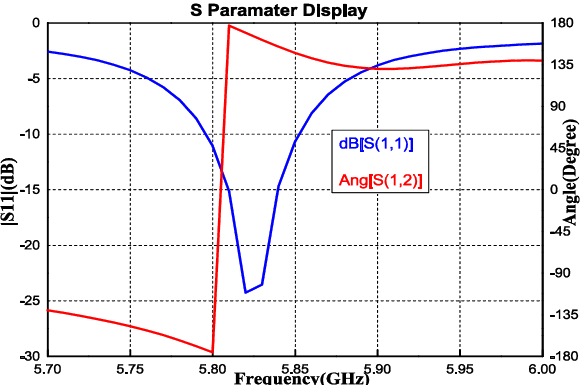
Figure 5: Expanded view of the S 11 (dB) and S 12 (phase angle)